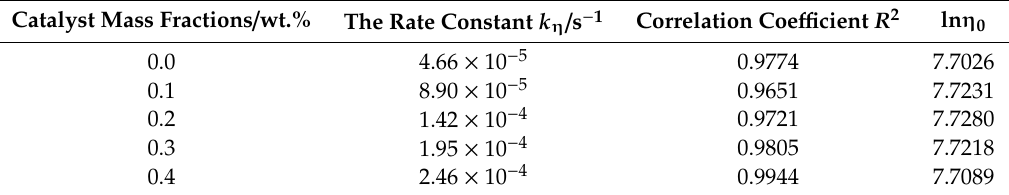
Table 2. Rheological parameters for the HTPB / HDI-trimer system in di ff erent mass fractions of the DABCO at 35 ◦ C. Catalyst Mass Fractions /